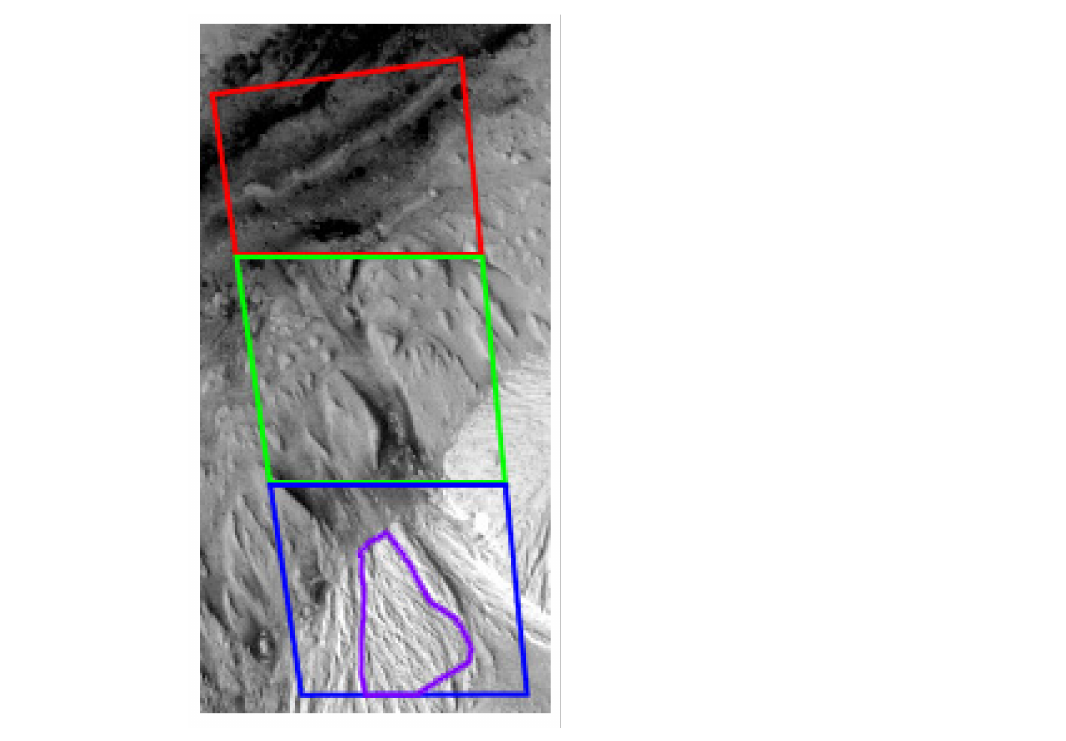
Figure 1. Study area for photoclinometry on the flank of Aeolis Mons in Gale crater, Mars. A portion of HRSC nadir image h4234_0001, orthorectified based on the HRSC USGS stereo DTM at 50 m ground sample distance (GSD) is shown. The HiRISE reference DTM T1 covers the combined area outlined. Colors indicate subareas with different slope and albedo properties for which results appear in Figures 9 and 10. Local albedo variability decreases and surface roughness increases from red to purple. Equirectangular projection with north at top, latitude of true scale 0 ◦ N, 7 × 13.75 km, centered near − 4.8 ◦ N, 137.8 ◦